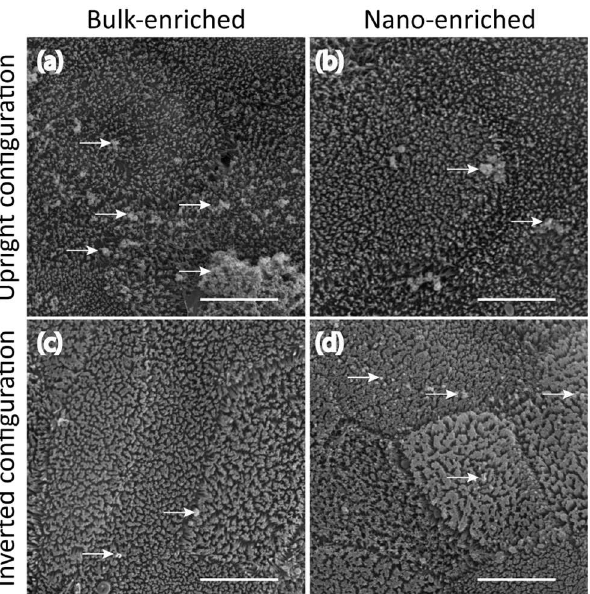
Fig 5. SEM micrographs of human intestine in vitro cell models exposed to gum-E171 nano- or submicron-enriched fractions. (a) Epithelia exposed to 1 μ g/mL of submicron-enrichedfraction in the upright configuration resulted in a large number of particles (white arrows) decoratingthe surface of the epitheliumafter 7 minutes of exposure. (b) However, exposingreplicate samples to the nano-enriched fraction with 1 μ g/mL for 7 minutes in the upright configuration resulted in few particles adheredto the epithelialsurface. (c) Inverting the epitheliumand subsequently exposingthe cells with 1 μ g/mL of the submicron-enriched fraction for 7 minutes resulted in few particles adheredto the epithelialsurface. (d) However, exposingreplicate samples in the inverted configuration to 1 μ g/mL of the nano-enriched fraction for 7 minutes resulted in relatively more particles adheredto the epithelialsurface. All images are shown at identicalmagnification. Scale bar is 5 μ